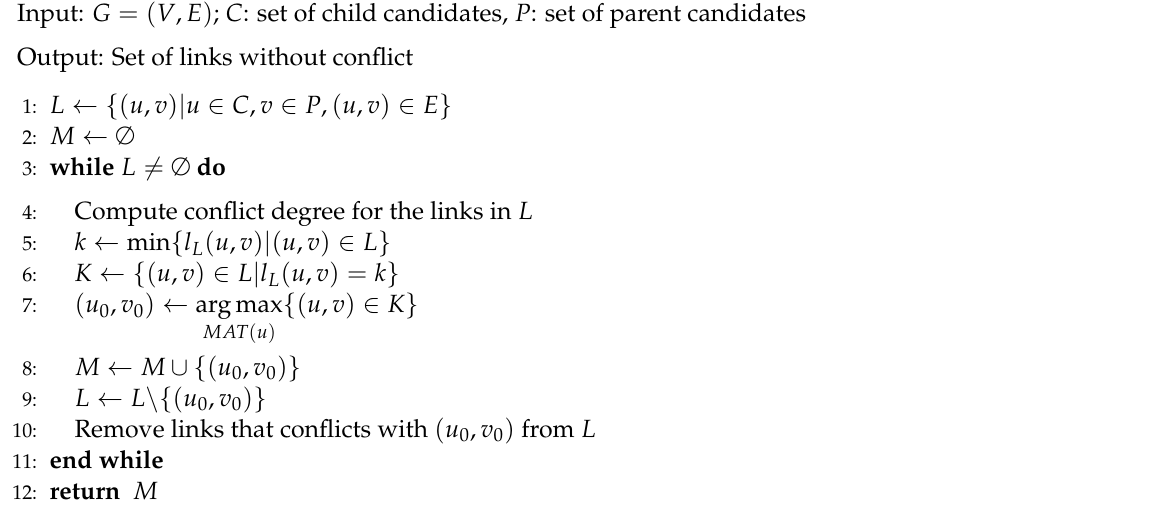
Algorithm 4 Delay-aware Maximum